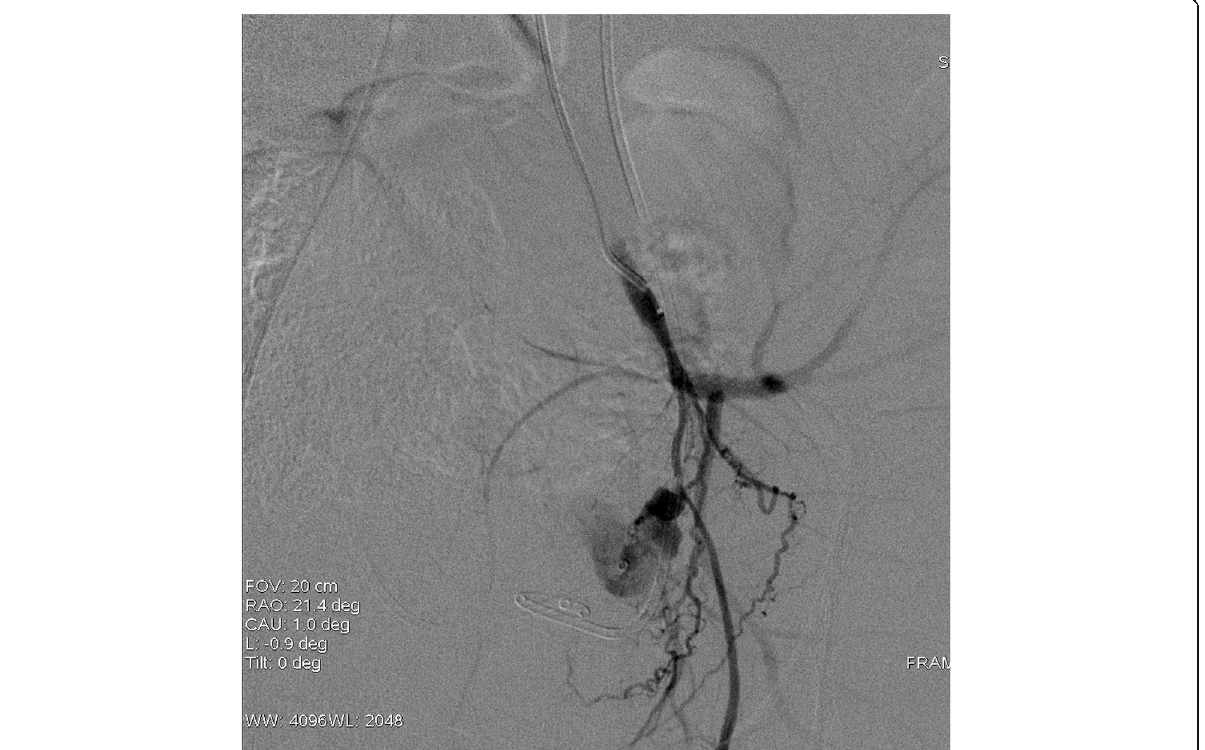
Fig. 1 Selective angiography of LIIA demonstrated an extravasation from a 3 mm pseudoaneurysm from the branch of anterior division of left internal iliac